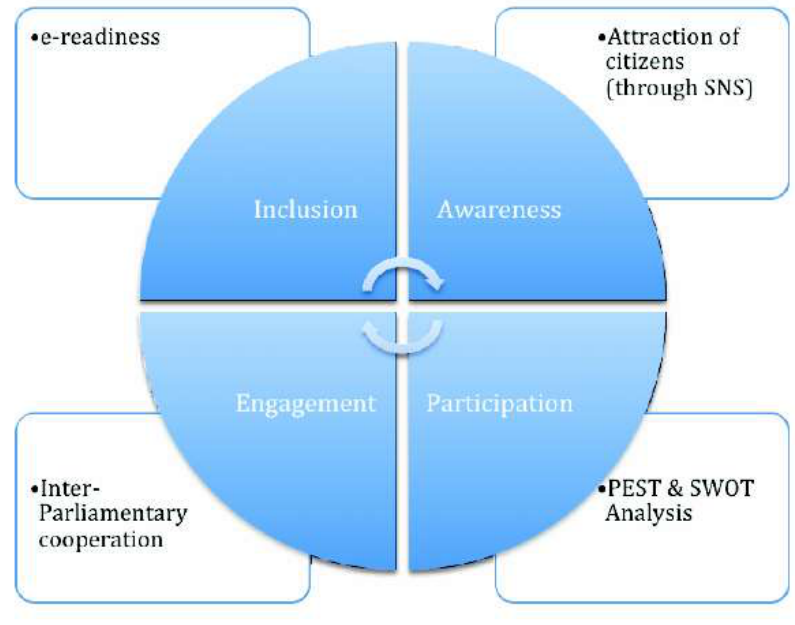
Figure 2: Strategic planning for e-Parliament